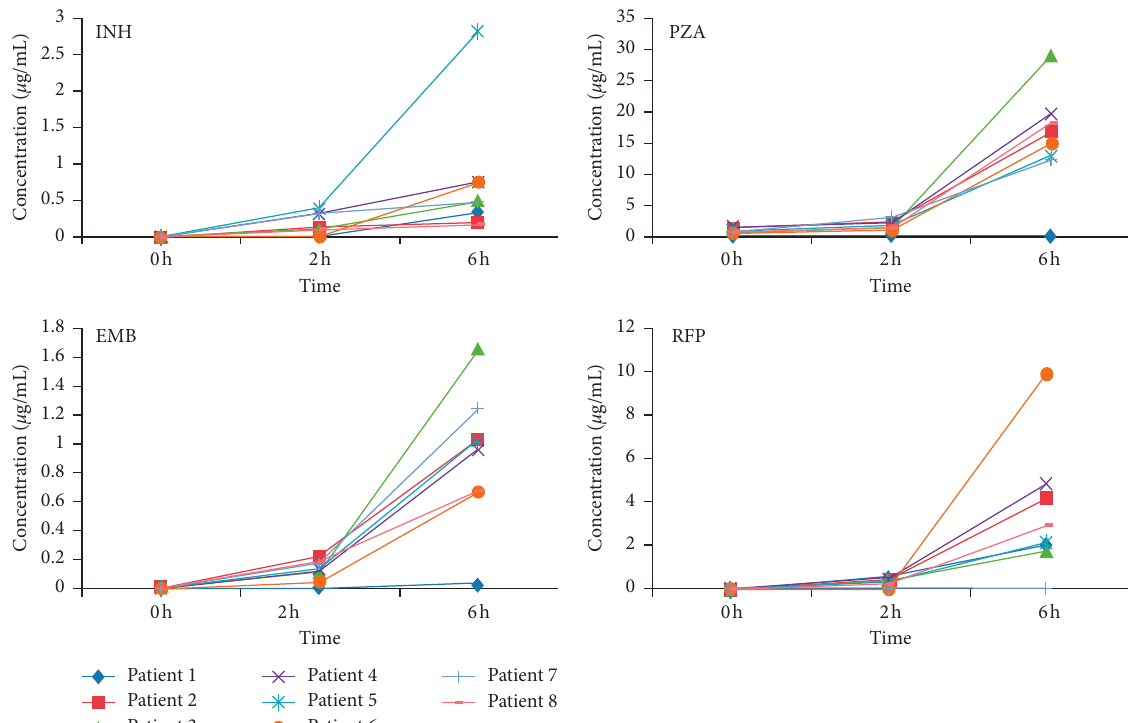
Figure 4: Serum concentrations of four first-line antituberculosis drugs at 0h, 2h, and 6h from eight